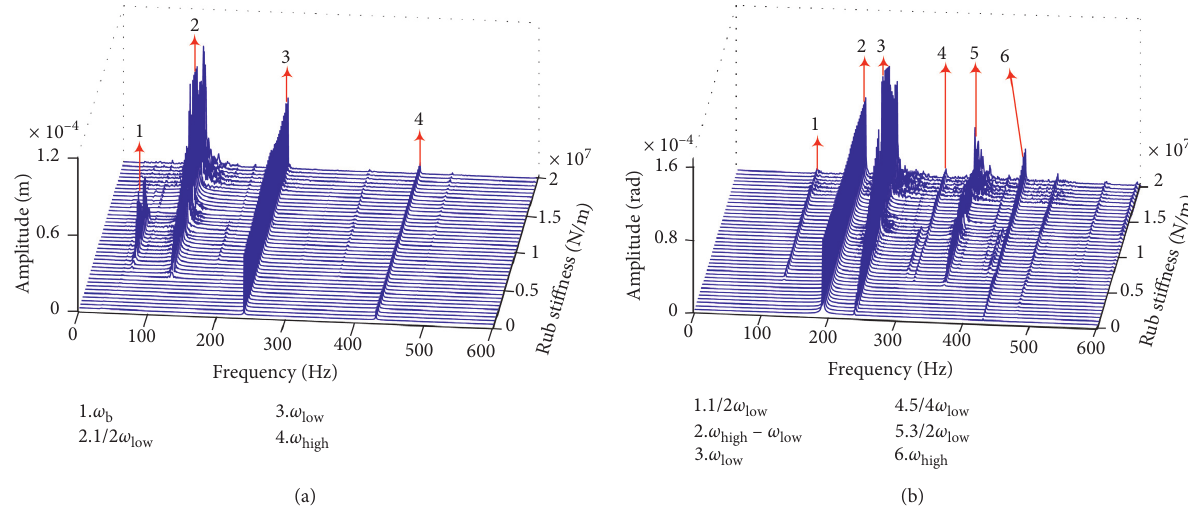
Figure 13: Spectrum cascades of the bending and torsional motions with varied rub-impact stiffness ( k (a) Bending motion and (b) torsional motion.